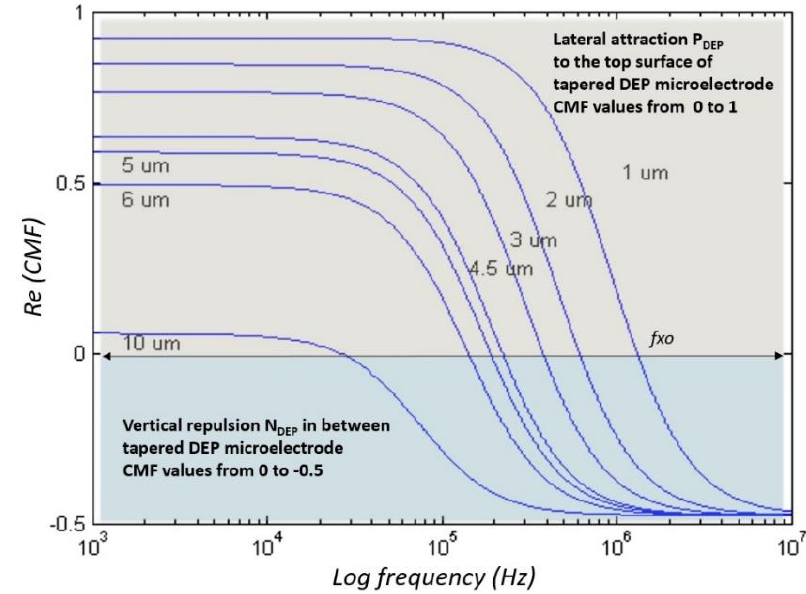
Figure 6. The polarisation factor of the Clausius – Mossotti factor (CMF) for Ps.